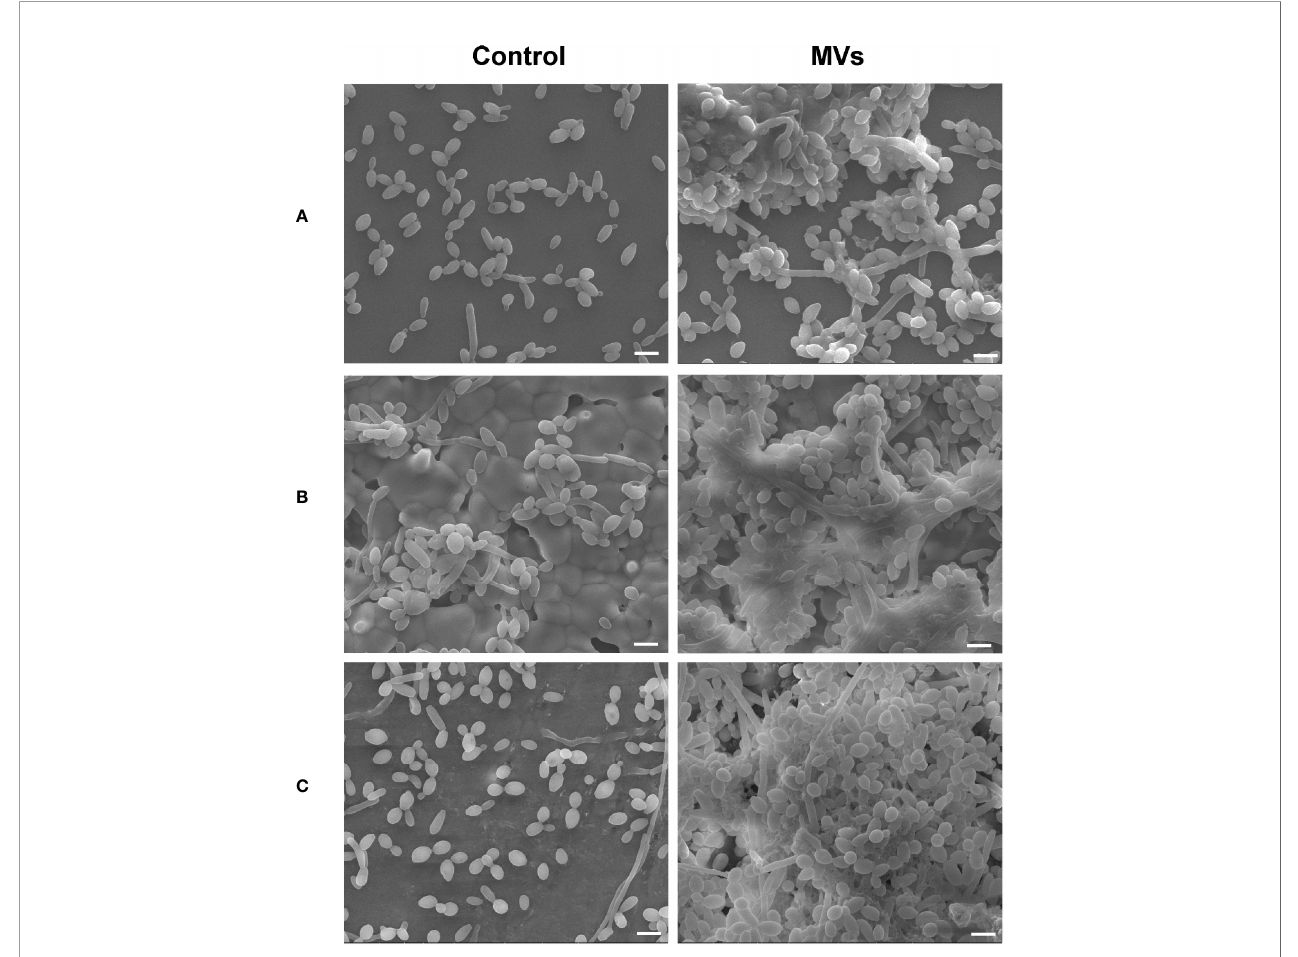
FIGURE 1 | The effect of S. mutans MVs on C. albicans bio fi lm formation. C. albicans bio fi lms were developed on (A) cover glasses, (B) hydroxyapatite discs, and (C) bovine dentin specimens. Scale bar, 5 m